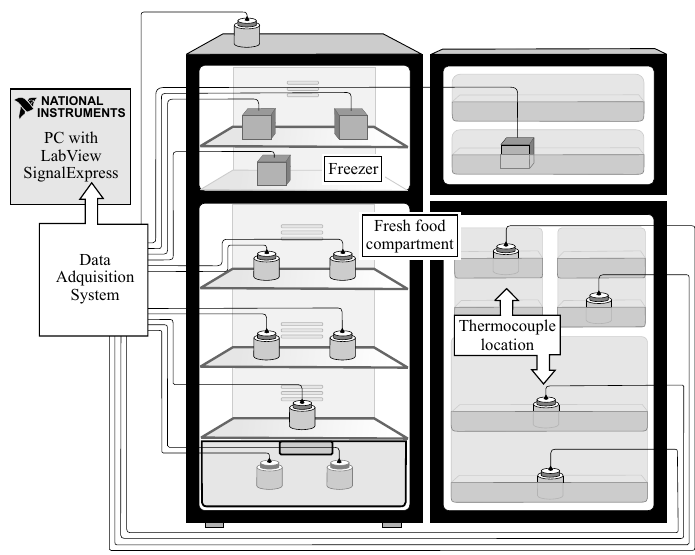
Figure 1. Scheme of the experimental